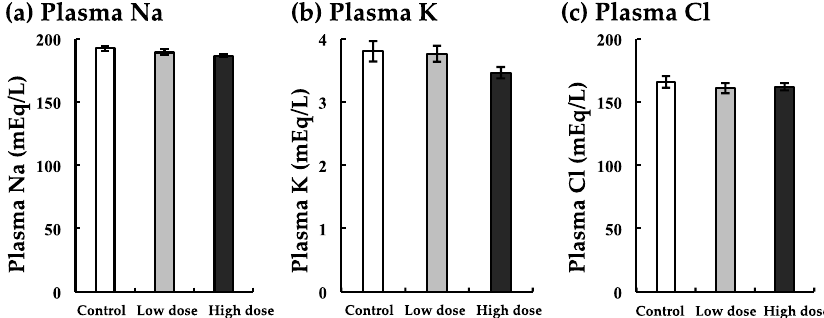
Figure 6. Changes in Na (a), K (b), and Cl (c) levels with BaA treatment. BaA (1 or 10 ng/g body weight) was injected intraperitoneally (four times) into nibbler fish for 10 days during breeding. Thereafter, plasma Na, K, and Cl were examined in the control and experimental groups. There was no significant difference between the control and experimental groups (n = 8). The detection limits of Na, K, and Cl were 10, 1, and 10 mEq/L, respectively.